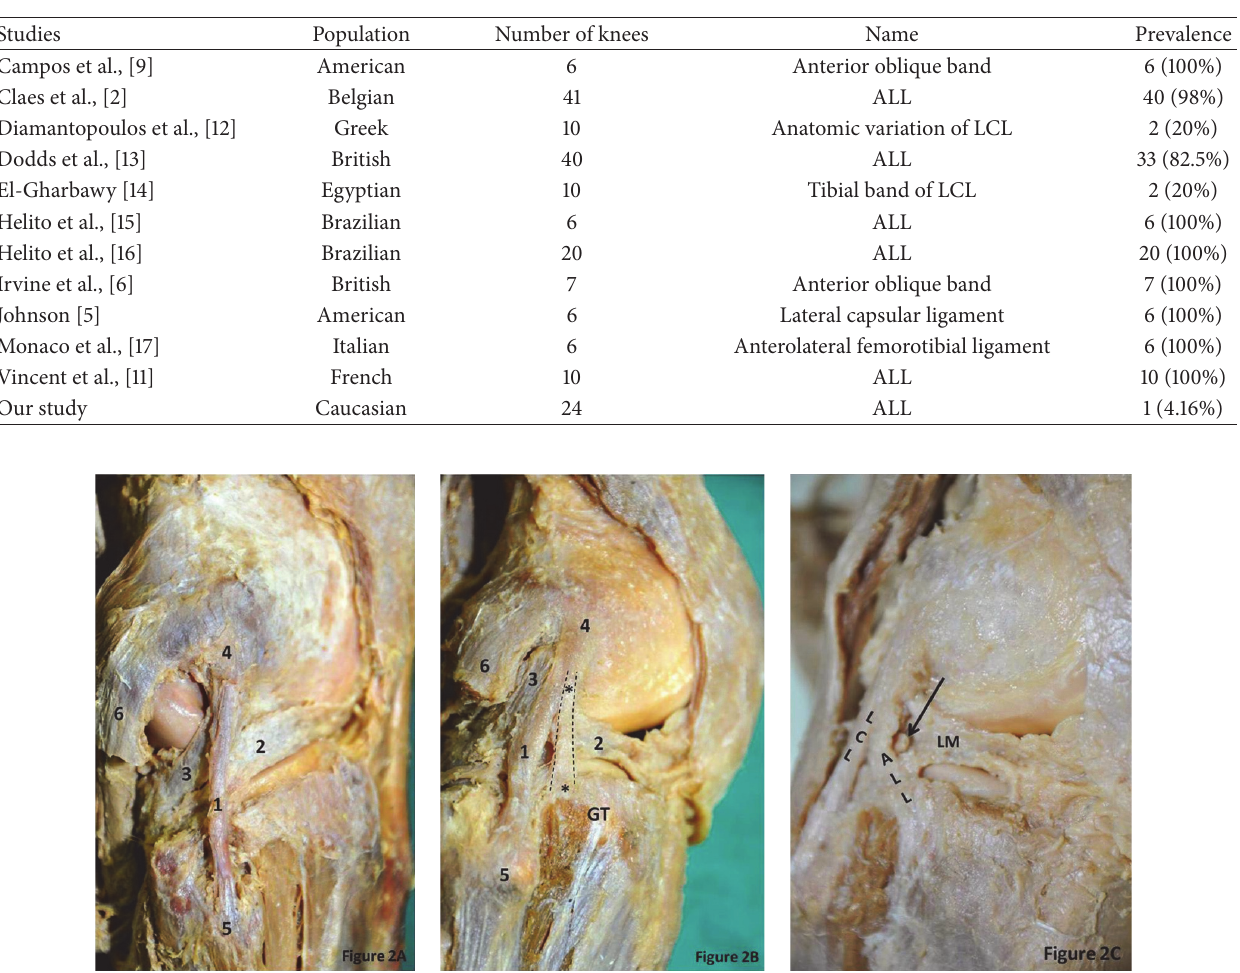
Table 2: Showing cadaveric studies and their ALL prevalence reported in literature.